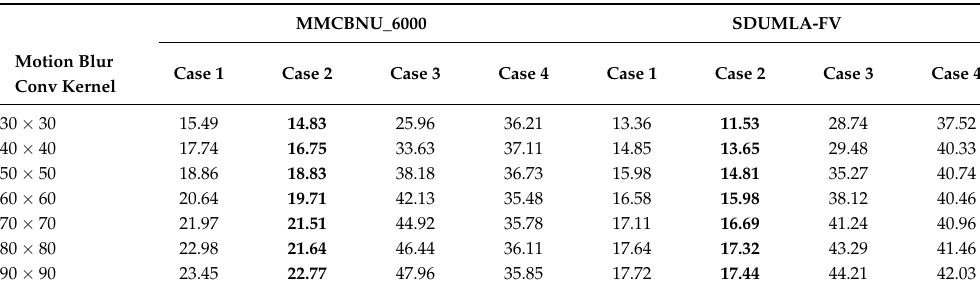
Figure 7. The ROC curves of various deblurring methods on the different public datasets. Table 2. EERs (%) of MMCBNU_6000 and SDUMLA-FV with different motion blur kernels text